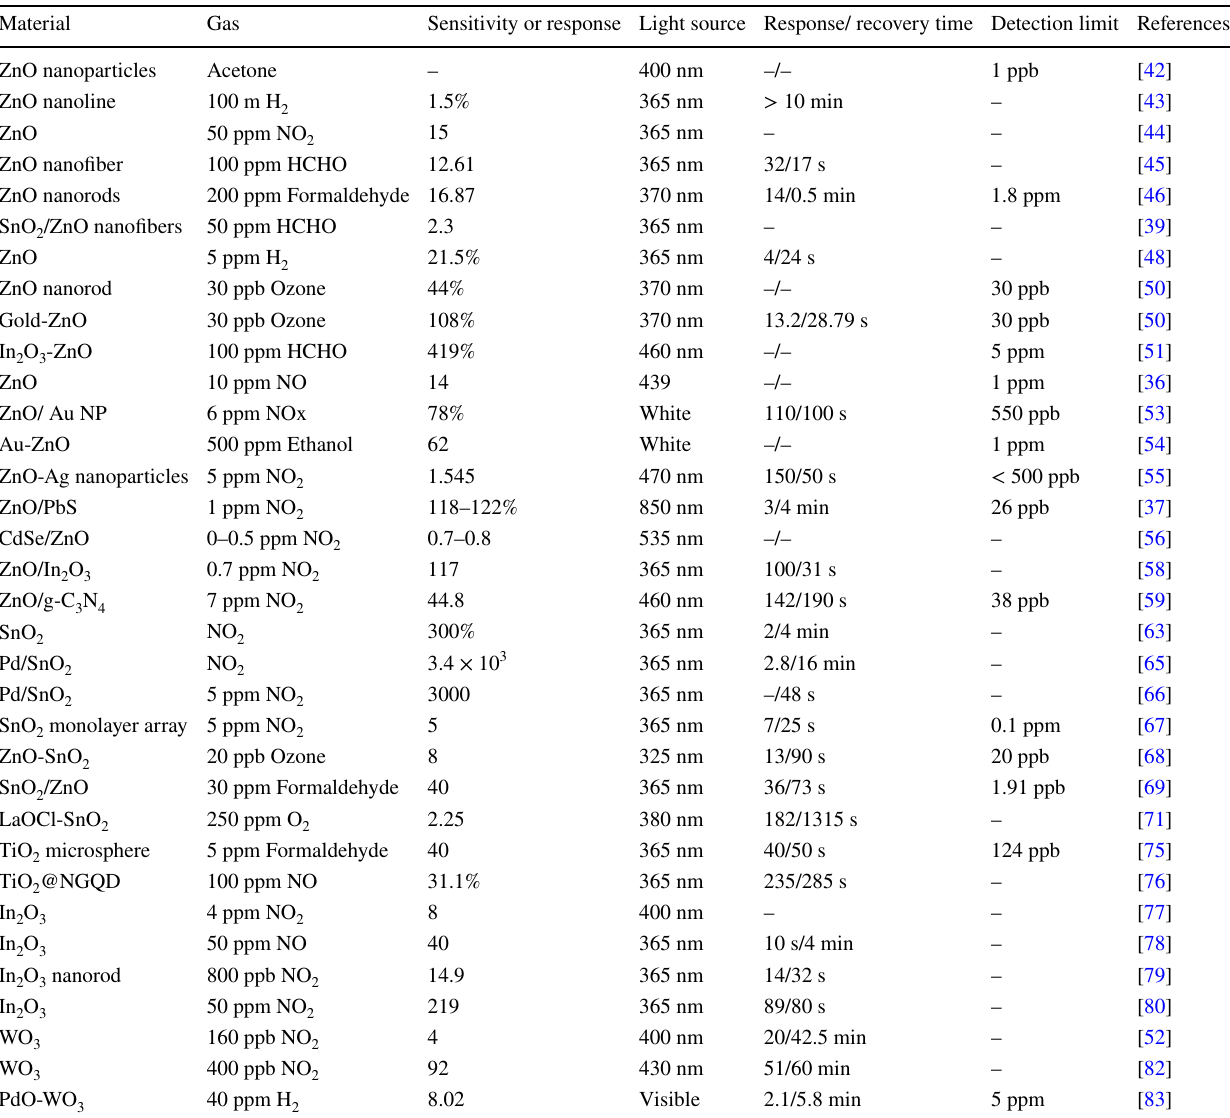
Table 1 Summary of metal oxide gas sensors to various gases under photoactivation at room temperature